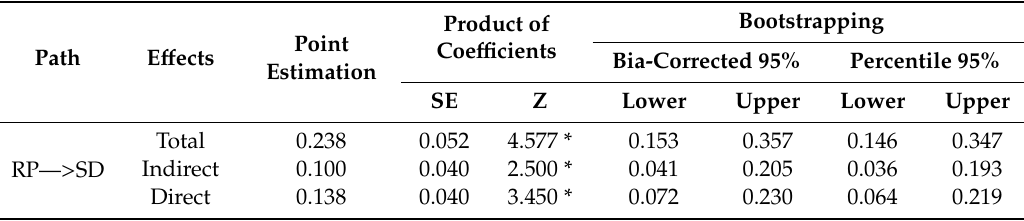
Table 7. Mediating e ff ect (Bootstrapping 5000 times).